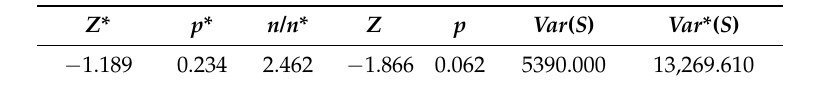
Table 2. The results of the trend analysis carried out by the modified Mann–Kendall (MMK) test for the sewage outflow during the analyzed period of time.